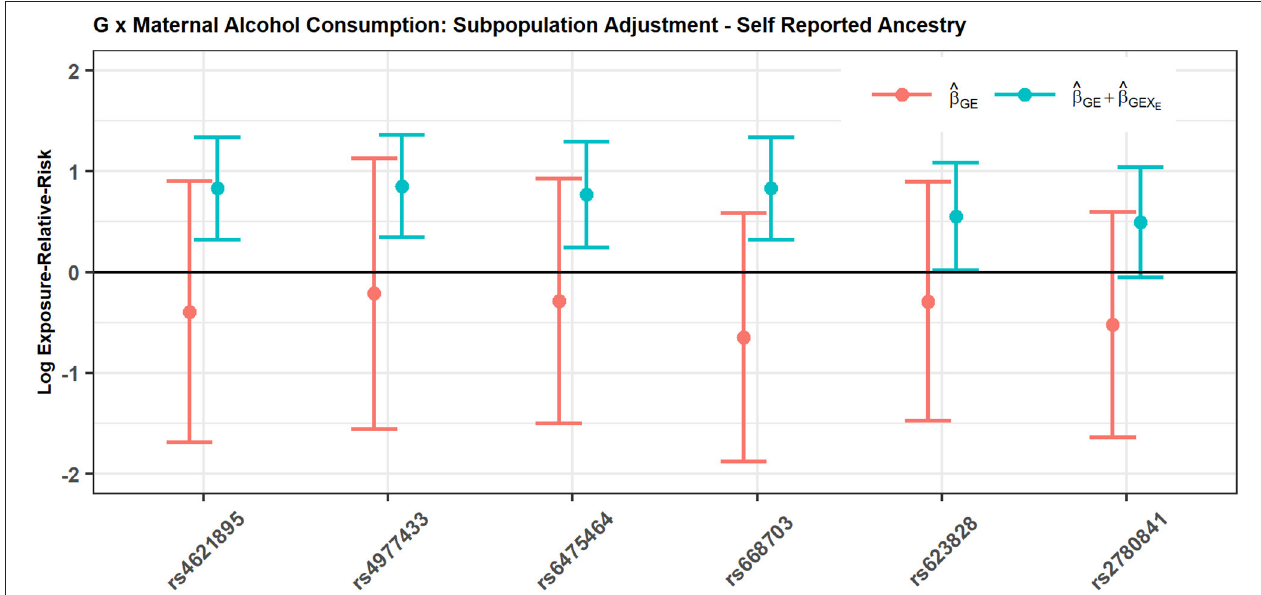
FIGURE 2 | SNPs in MLLT3 gene show significant interaction with Maternal Alcohol Consumption among European CP trios, but not among East Asian CP trios.